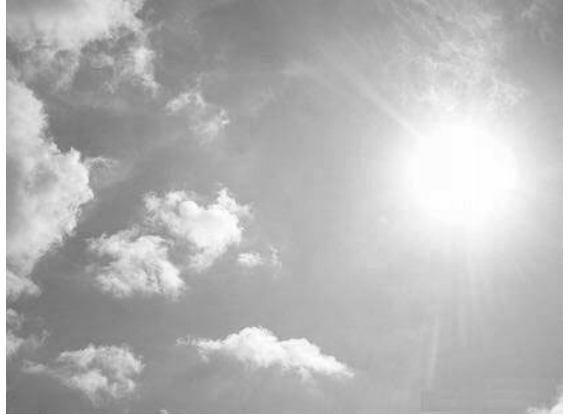
Figure 2. The grayscale image transformed from the RGB image.